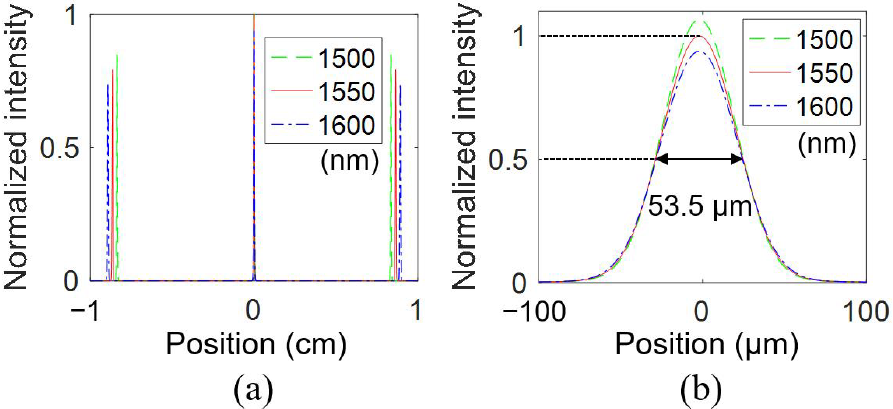
Figure 5. ( a ) Simulated far field intensity distributions of the waveguide lens at different wavelengths. ( b ) Zoom-in view of the intensity distributions of the zero-order diffraction at different wavelengths.